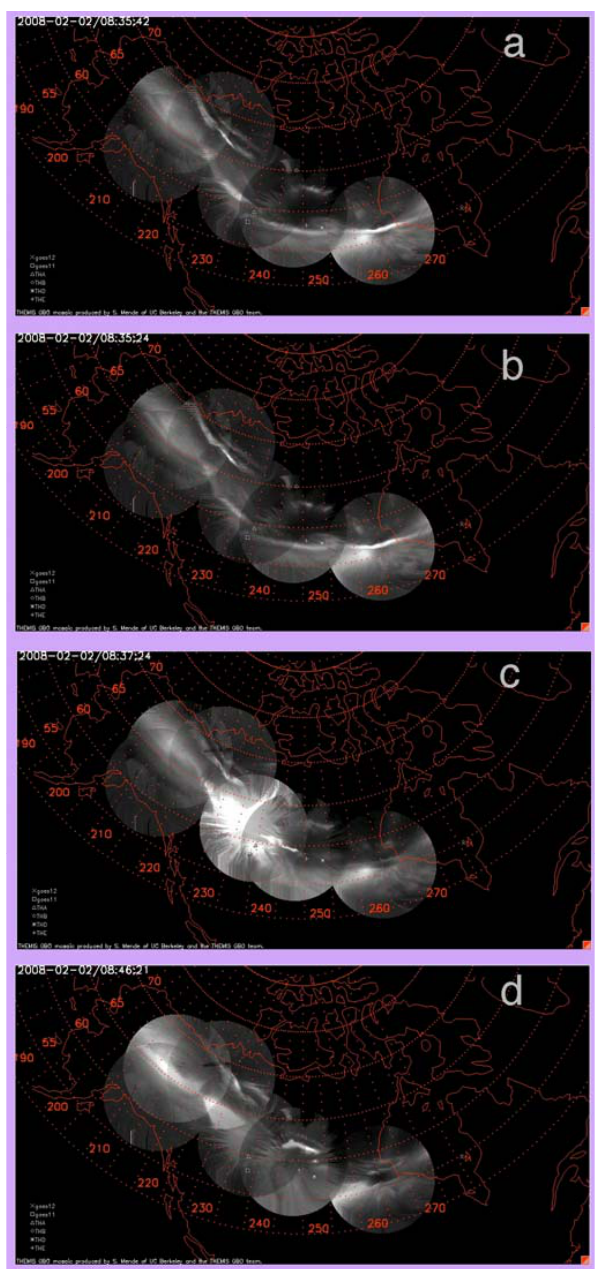
Fig. 19. Image collage representation of the ∼ 836 event, Figure 19. Image collage representation of the ~836 event, (a) 8:35:42 ground base (a) 08:35:42 ground base onset of the substorm poleward expan- onset of the substorm poleward expansion phase (b) 8:35:24 magnetic signal arrival at sion phase (b) 08:35:24 magnetic signal arrival at THEMIS A THEMIS A (c) 08:37:24 arrival at THEMIS B (d) 8:46:21 magnetic impulse reaches (c) 08:37:24 arrival at THEMIS B (d) 08:46:21 magnetic impulse satellite THEMIS E. reaches satellite THEMIS E.